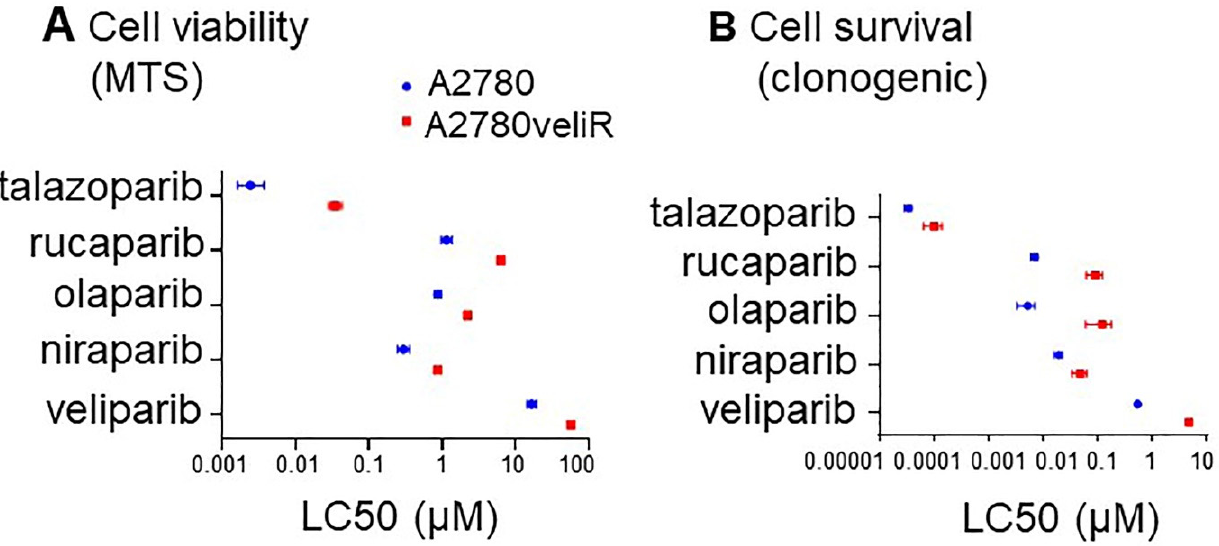
Figure 2. Talazoparib, rucaparib, olaparib or niraparib cannot rescue acquired veliparib resistance in the A2780veliR cell line model. ( A ) LC50 calculated from cell viability (MTS assay) data post treatment with a PARPi. ( B ) LC50 calculated from cell survival (clonogenic assay) data post treatment with a PARPi.